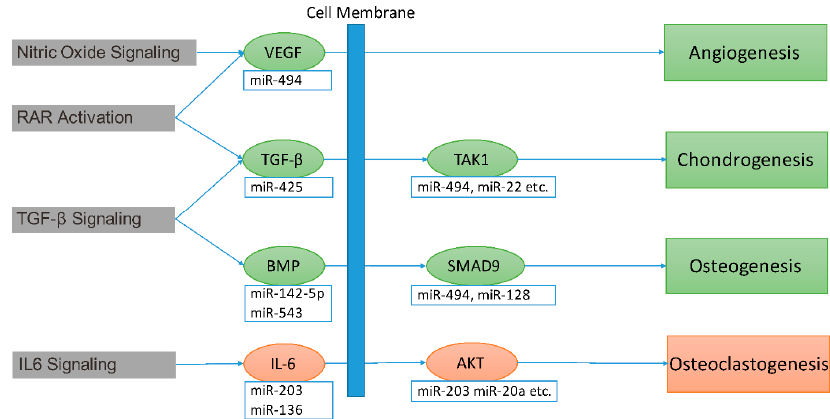
Figure 5. The effect of top 100 highest RCIFH miRNAs on the key genes of nitric oxide signaling, retinoid acid receptor (RAR) activation, transforming growth factor- β (TGF- β ) signaling, and interleukin 6 (IL-6) signaling pathways in impaired fracture healing. Red: gene expression and function are activated in aged female mice compared to adult ones. Green: gene expression and function are inhibited in aged female mice compared to adult ones.